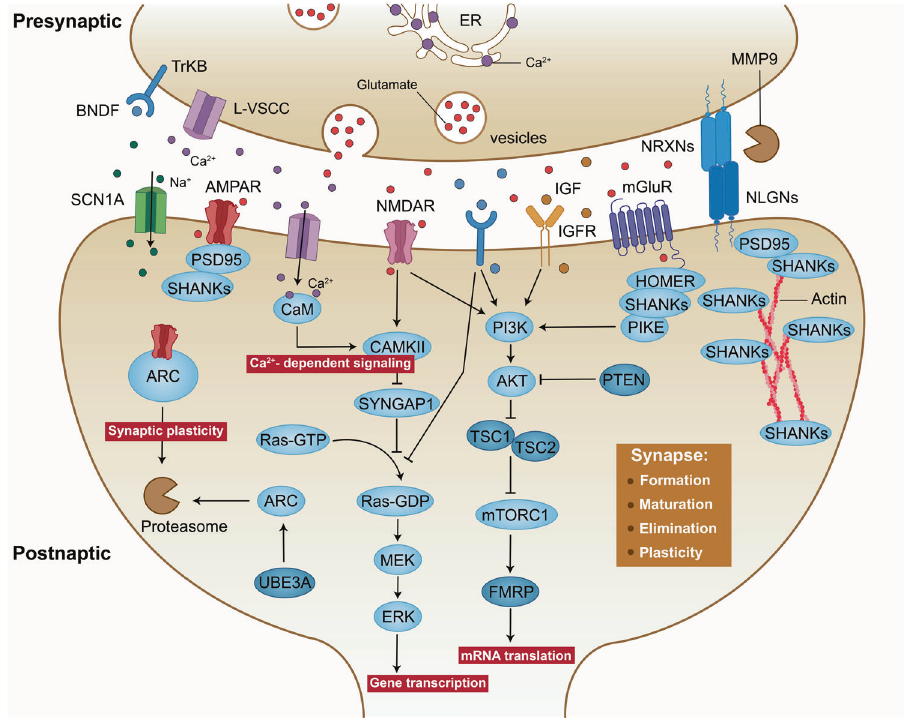
Fig. 4 Molecular pathways implicated in synaptic function for ASD. At the excitatory synapse, encoded proteins including synaptic scaffold proteins (for example, SHANKs), neurotransmitter receptors (for example, NMDARs, AMPARs and mGluRs) and cell adhesion molecules (NRXNs and NLGNs) associated with autism risk genes. Activation of cell surface receptors is closely linked to activation of the Ras/ERK and PI3K/AKT/ mTOR pathways. In addition, mutations in ion channels, such as L-VSCCs and sodium channel protein type 1 subunit- α (SCN1A), both of which have been illuminated result in synaptic dysfunction and autism-like